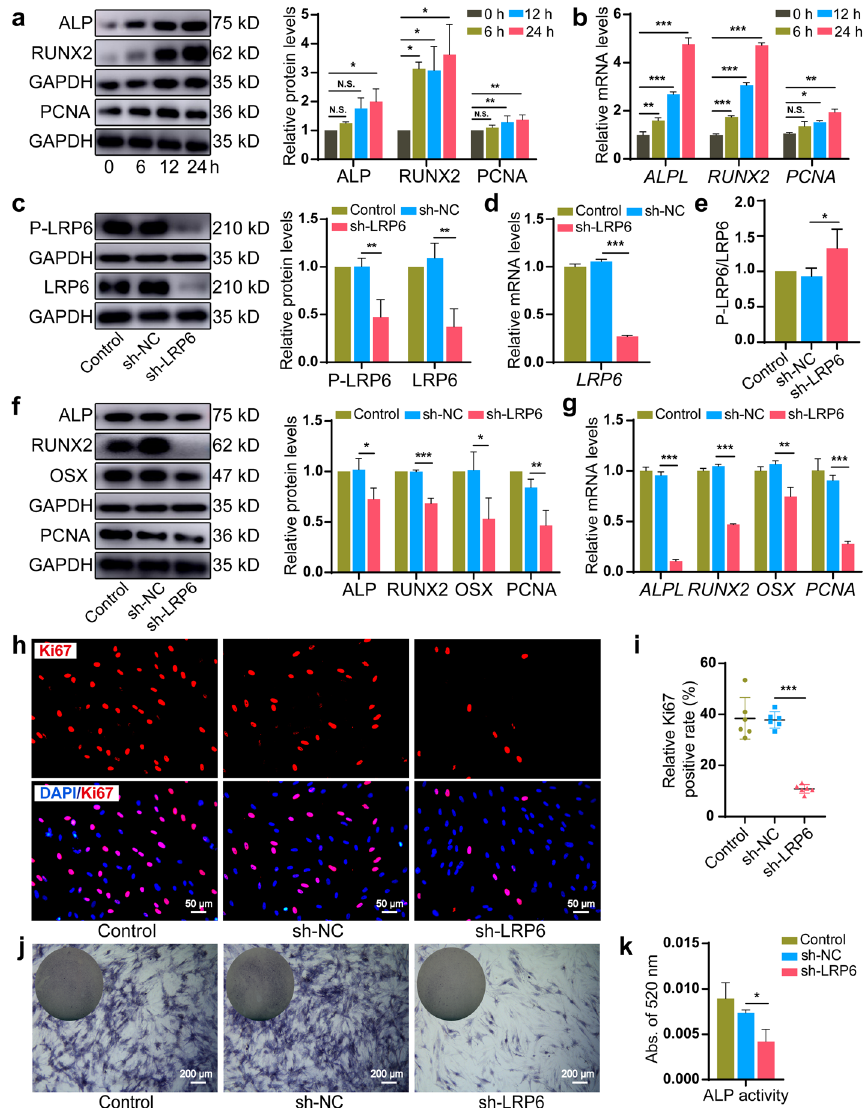
Fig. 2 LRP6 inactivation inhibited osteogenic commitment in force-induced PDLSCs. a The protein expression of ALP, RUNX2, and PCNA in PDLSCs under CSS. b The mRNA expression of ALPL , RUNX2 , and PCNA in PDLSCs under CSS. c The protein expression of P-LRP6 and LRP6 in the control, sh-NC, and sh-LRP6 group after stretching for 24 h. d The mRNA expression of LRP6 in the control, sh-NC, and sh-LRP6 group after stretching for 24 h. e The ratio of the protein levels of P-LRP6/total LRP6 in the control, sh-NC, and sh-LRP6 group after stretching for 24 h. f The protein expression of ALP, RUNX2, OSX, and PCNA in the control, sh-NC, and sh-LRP6 group after stretching for 24 h. g The mRNA expression of ALPL , RUNX2 , OSX , and PCNA in the control, sh-NC, and sh-LRP6 group after stretching for 24 h. h , i Immunofluorescence and semi-quantitative analysis of Ki67 + cells in the control, sh-NC, and sh-LRP6 group after stretching for 24 h. Scale bar, 50 μm. j , k ALP staining and ALP activity analysis of the control, sh-NC, and sh-LRP6 group after stretching for 24 h. Scale bar, 200 μm. * P < 0.05, ** P < 0.01, *** P < 0.001. N.S., no significance. Results are presented as mean triplicated